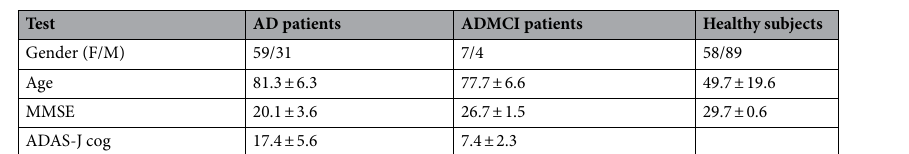
Table 1. Cognitive function test scores of AD patients, ADMCI patients, and healthy subjects. Data are mean ± SD. AD, Alzheimer’s disease; ADMCI, Mild cognitive impairment due to AD; MMSE,